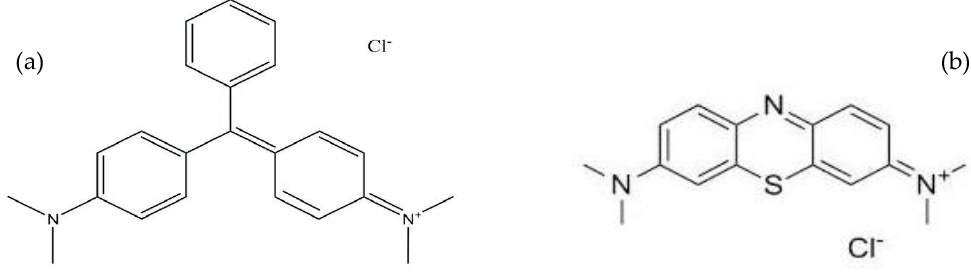
Figure 2. Molecular structure of ( a ) malachite green and ( b ) methylene